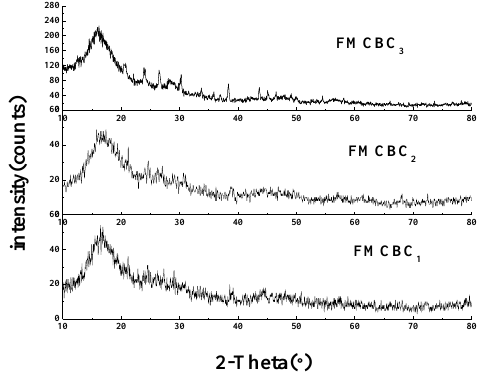
Figure 2. The X-ray diffraction pattern of FMCBC s.